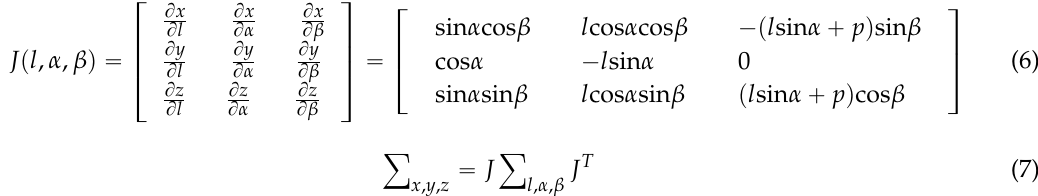
Figure 3. 2000 simulated observation points and error ellipsoids for r T